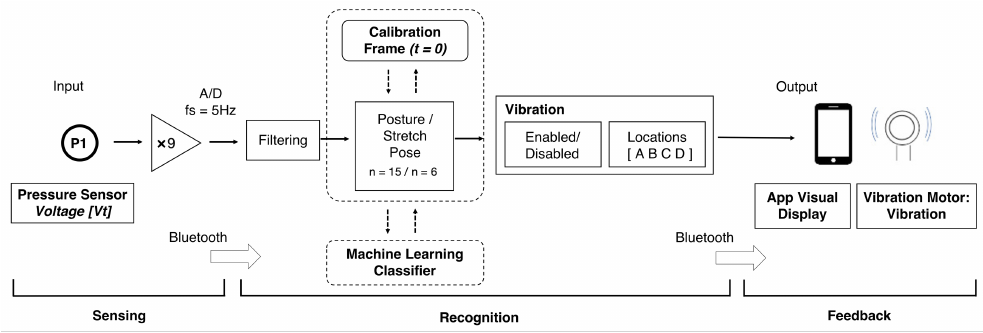
Figure 3. Workflow of our proposed system for machine learning-based sitting posture recognition using the LifeChair